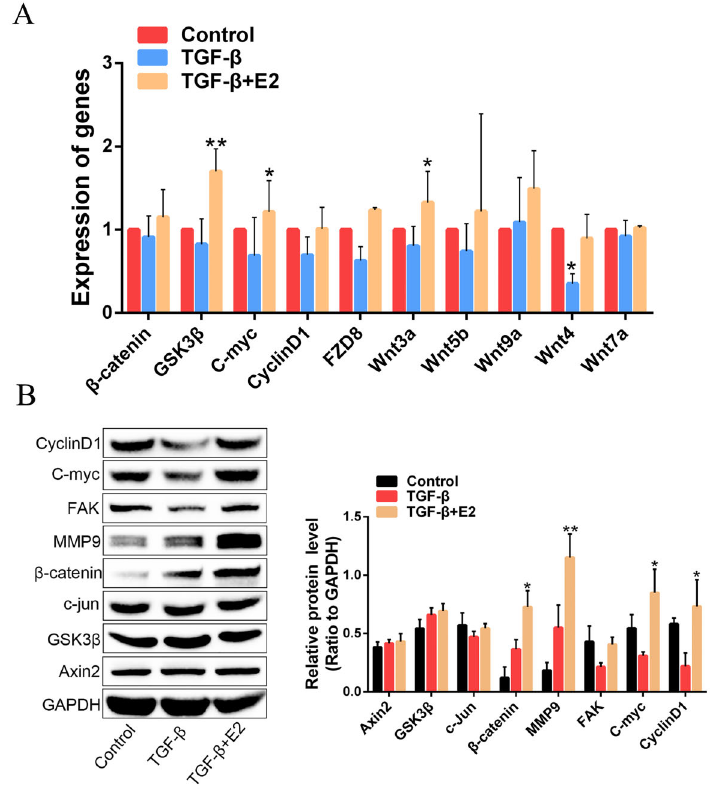
Figure 5. Estrogen (E2, 30 nM) inhibited intrauterine adhesion progression through activating the Wnt/ b -catenin signaling pathway. A , Expression levels of key components of Wnt/ b -catenin pathway were detected by RT-PCR assay. B , Protein expression levels of Wnt/ b - catenin pathway were analyzed by western blotting. Data are reported as means ± SD. *P o 0.05, **P o 0.01 compared to control